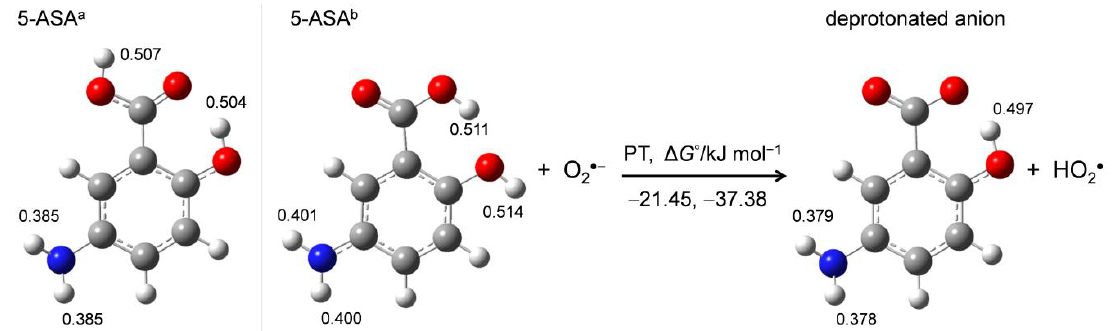
Figure 5. Different conformers of 5-ASA (5-ASA a , 5-ASA b ) and their deprotonated anion showing the initial PT calculated with DFT-B3LYP/PCM/6-311+G(d,p) in DMF. Calculated Δ G °s (kJ mol −1 ) for the PT and the charges distributed on the protons obtained by the NBO analysis are denoted.